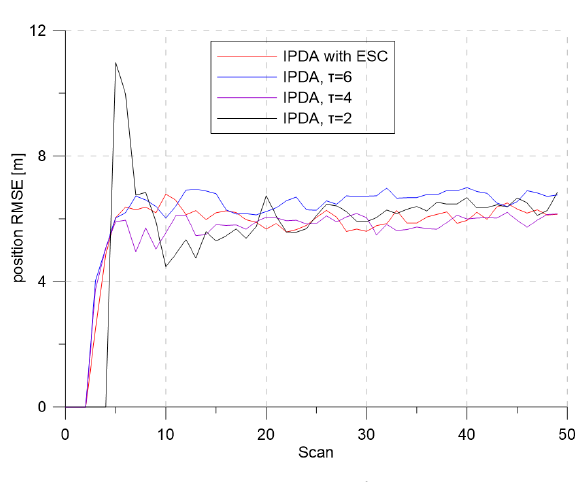
Figure 6. Position RMSE for λ = 1.2.